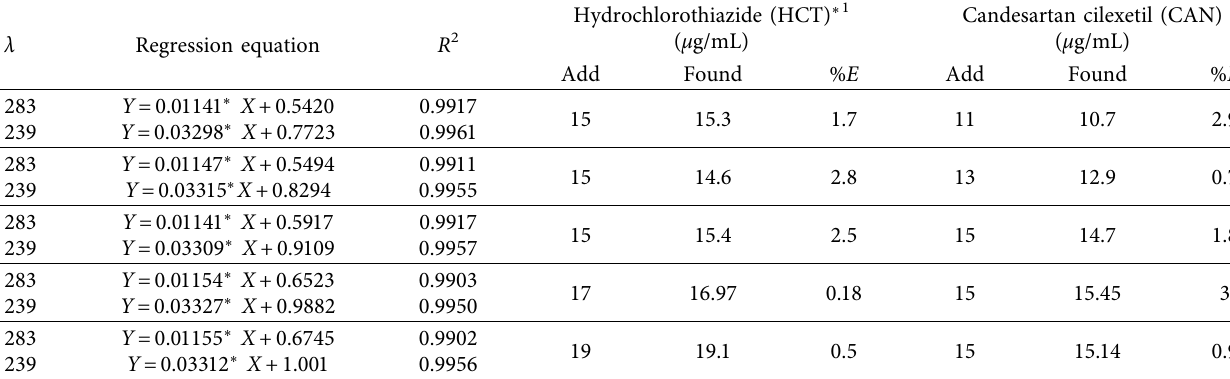
Table 7: Accuracy of the H -point standard addition method in the determination of HCT and CAN.